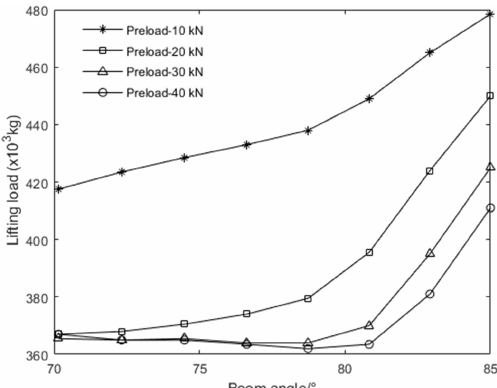
Figure 18. Instability loads of a telescopic boom under different preloads.